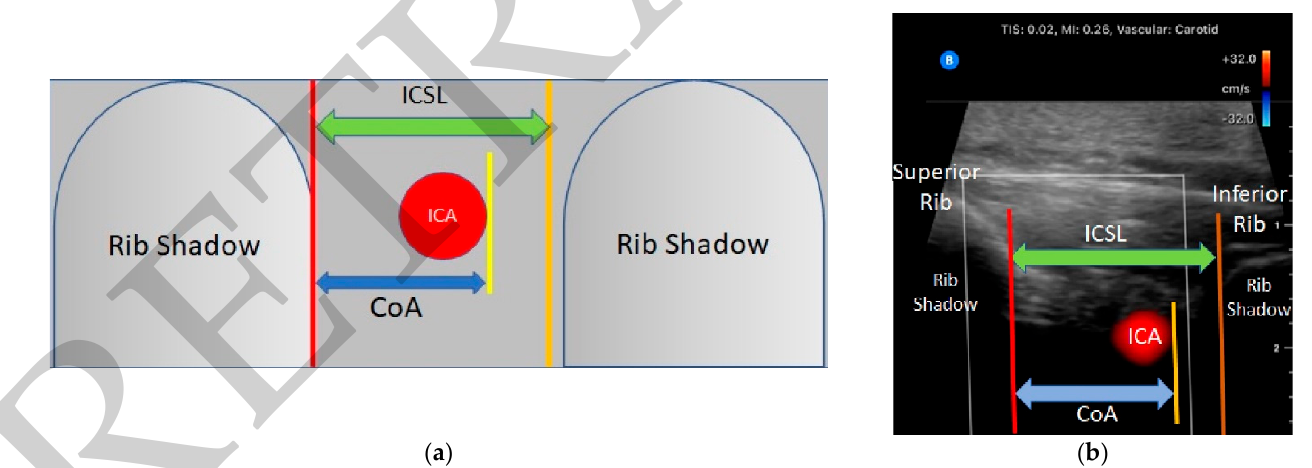
Figure 2. Ultrasound landmarks and measurements. ( a ) Schematic Representation, ( b ) Ultrasound View. Legend: Probe is oriented in a rostro-caudal plane with marker pointed towards the patient’s head. ICSL: Intercostal space length (green double arrow) represents the distance between the superior and inferior rib borders, ICA: Intercostal Artery, Costo-Arterial distance (CoA) represents the distance from the inferior border of the superior rib to the inferior border of the ICA (blue double